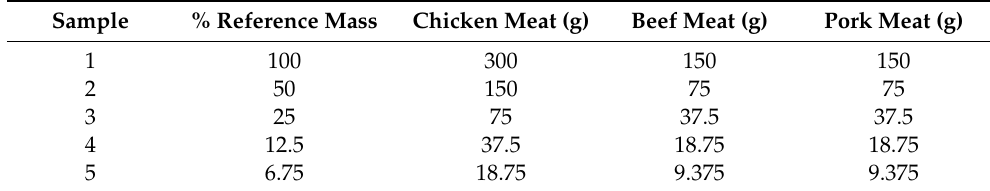
Table 5. Samples of decreasing fractions of meat for sensibility test.